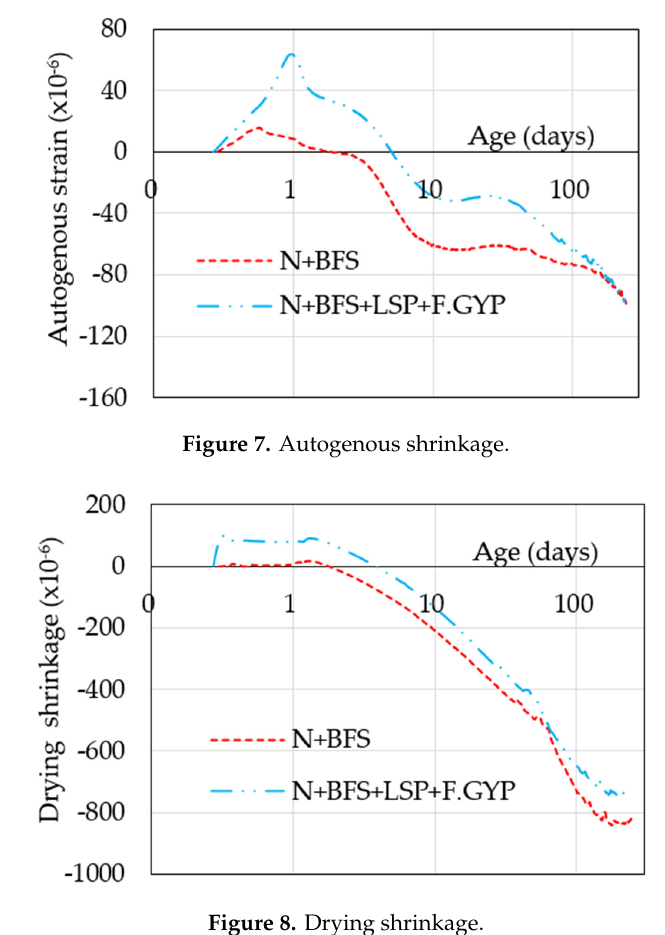
Figure 6. Temperature history for accelerated curing. N—ordinary Portland cement; BFS—ground granulated blast-furnace slag cement; LSP—limestone powder; F.GYP—fine gypsum.